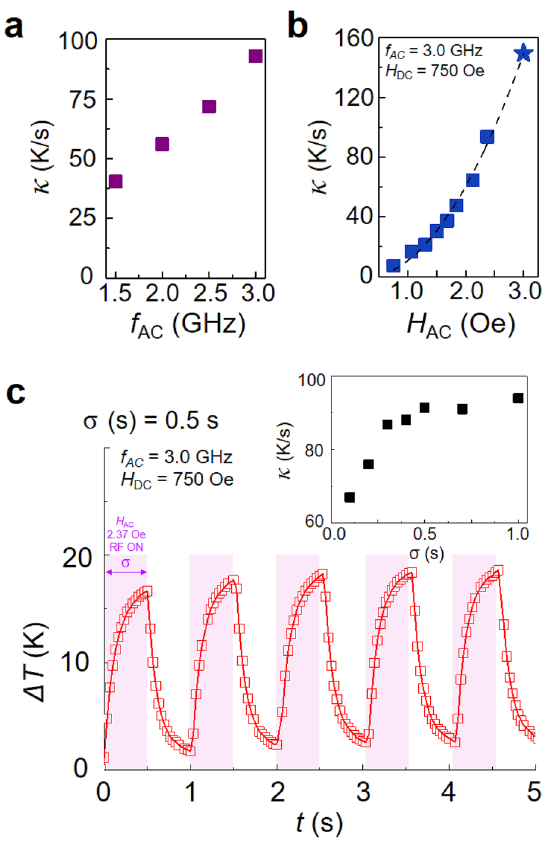
Figure 5. External field parameter dependence of initial temperature increment rate κ . ( a ) Maximum κ values versus f AC obtained from Fig. 4b. ( b ) κ values versus H AC at resonance under application of 1-s-duration pulse of RF field at f AC = 3.0 GHz with H DC = 750 Oe. The blue star symbol corresponds to κ = 150 K/s found at H AC = 3 Oe, which was the highest value observed in our experiments. The dashed curve indicates a quadratic 2 fit ( κ = 15.82 H AC ) to the experimental data. ( c ) Temperature increments for periodic pulses (pulse width σ = 0.5 s) of resonant RF magnetic field of f AC = 3.0 GHz and H DC = 750 Oe at H AC = 2.37 Oe. The inset shows the κ variation with the pulse width